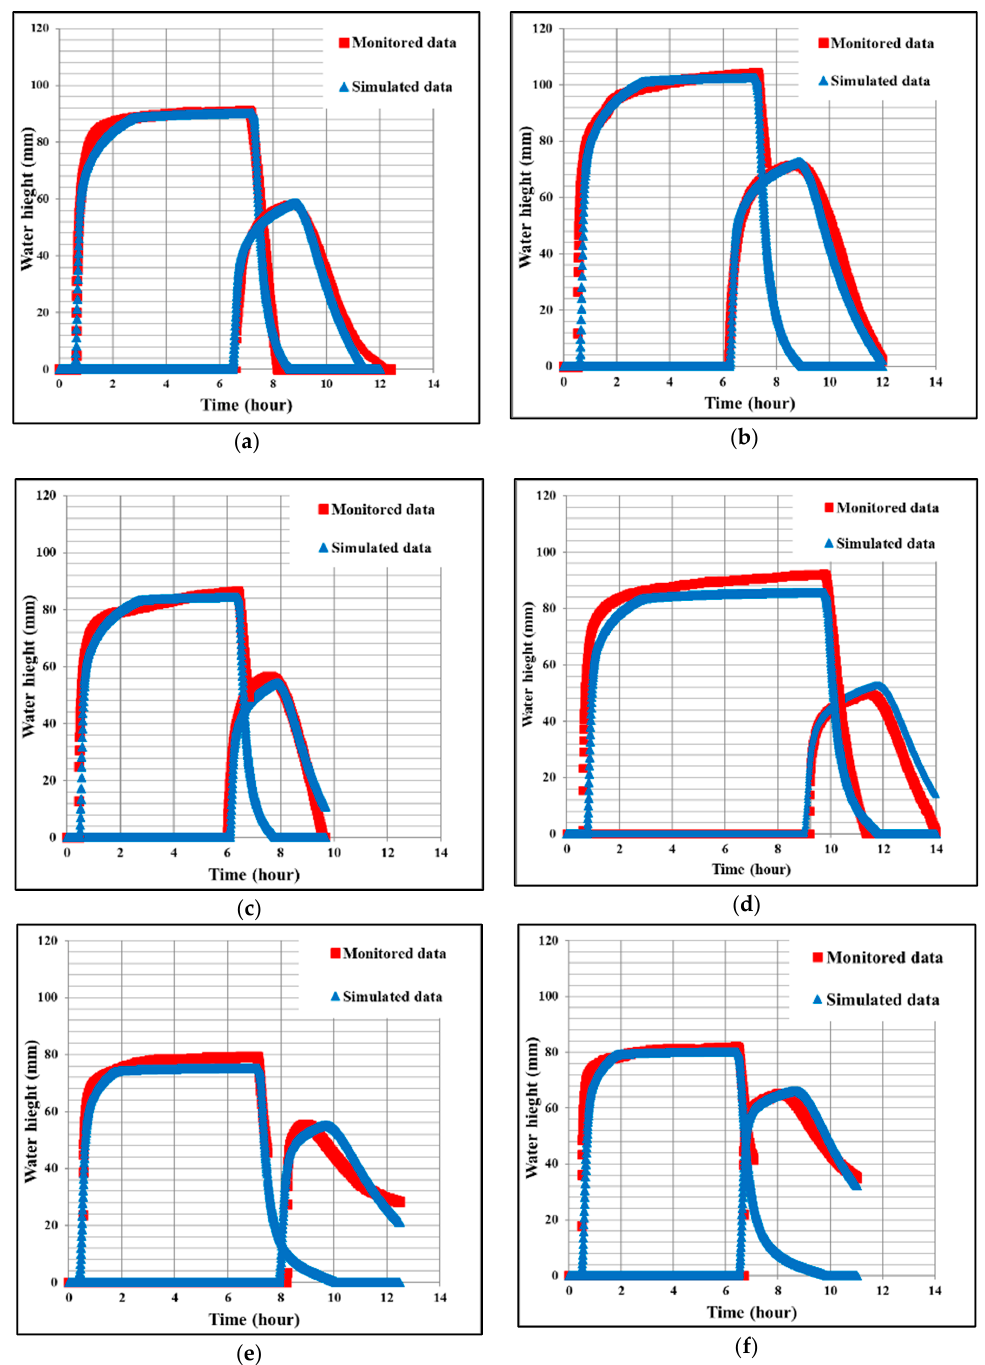
Figure 4. Comparison between simulated (blue triangles) and measured (red squares) water depth hydrographs in the upstream and downstream sections of the field. Simulations were performed with the fitted set of soil parameters. On each figure the first curve (on the left part of the X-axis) was obtained on the upstream section, whereas the second curve (on the right part of the X-axis) was obtained on the downstream section. ( a ) is for irrigation A1; ( b ) for irrigation A2; ( c ) for irrigation A3, ( d ) for irrigation A5; ( e ) for irrigation B6 and ( f ) for irrigation B7. Table 5. Values of the performance criteria calculated during the verification step of the fitting process. CNASH is the Nash criterion. RMSE is the Root Mean Square Error between simulated and measured data.